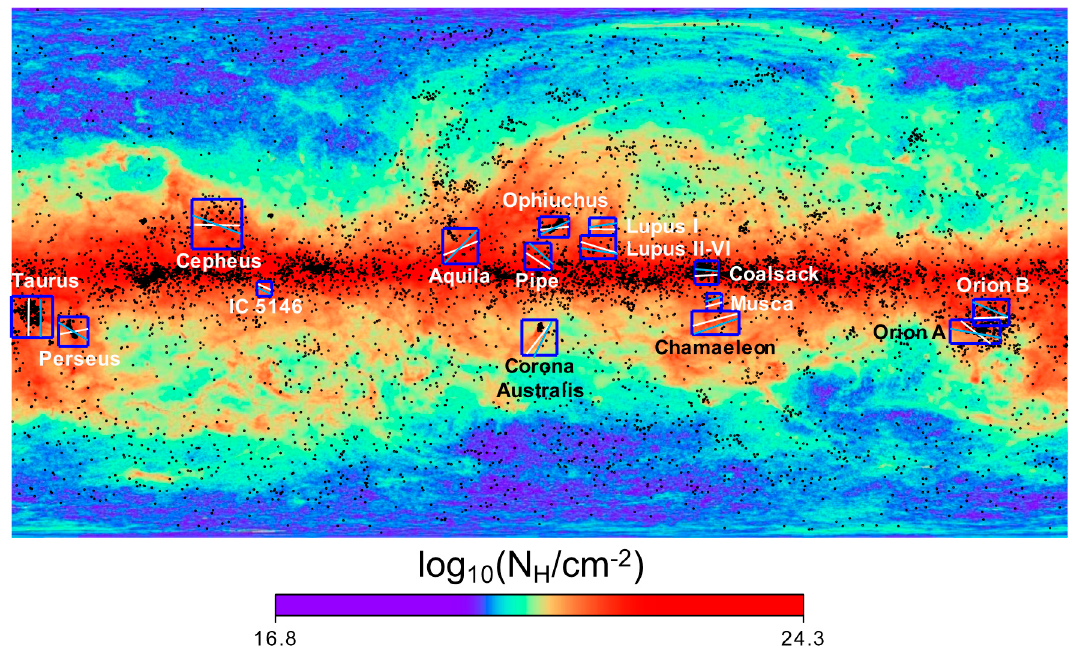
Figure 6. Spatial distribution of all stars (black dots) in [31]. The colours represent the total gas column density (in logarithmic scale). The blue rectangles show the locations of all the Gould Belt clouds. Blue and white line segments show the average B-field orientations, inferred from starlight and Planck 353 GHz thermal dust polarization, respectively [32].